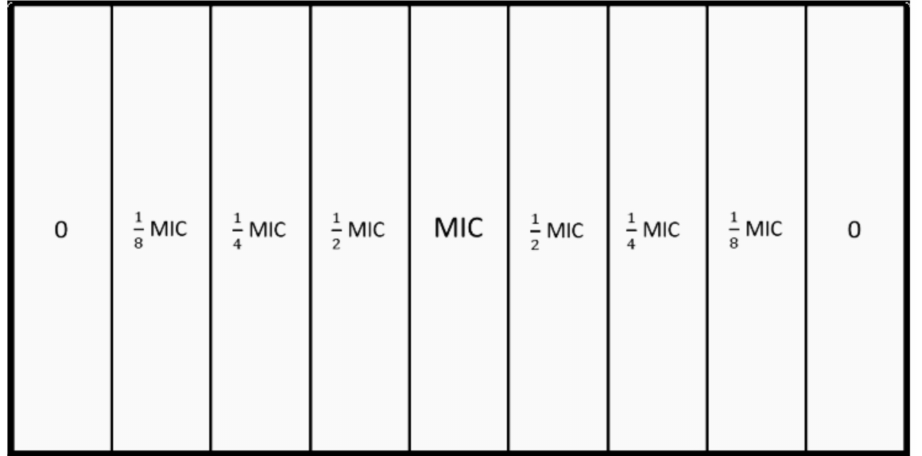
Figure 5. Schematic representation of the different nisin concentrations tested in each internal division of the MEGA plate. The MIC value of 22.5 µ g/mL was previously assessed. The 1 / 2 MIC division corresponds to a nisin concentration of 11.25 µ g/mL, the 1 / 4 MIC division corresponds to a nisin concentration of 5.625 µ g/mL, and the 1/8 MIC division corresponds to a nisin concentration of 2.8125 µ g/mL. Suspensions were inoculated along the plate extremity, at division 0. Then, a suspension of the reference strain S. aureus ATCC 29213 (with 10 8 CFU/mL) was inoculated on the left extremity of the MEGA-plate, and a suspension of a selected DFI isolate, S. aureus Z.25.2, was inoculated on the right extremity, in an area of 1 cm of thickness. The plates were incubated at 37 ◦ C for a period of 15 days and, each day, the growth of the staphylococci was accessed and registered via time-lapse photography twice a day using a Canon®M50 camera, in order to evaluate the bacterial multiplication progress through time (Figure 6).